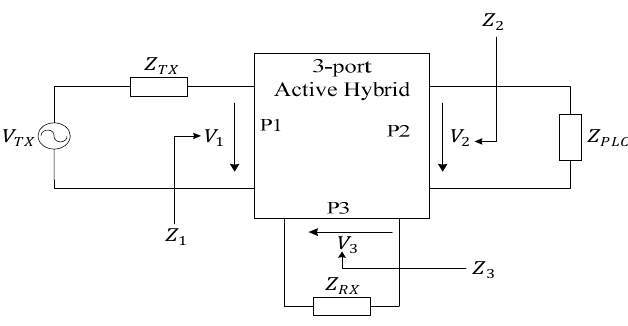
Figure 10. Port connections of the active hybrid [127].